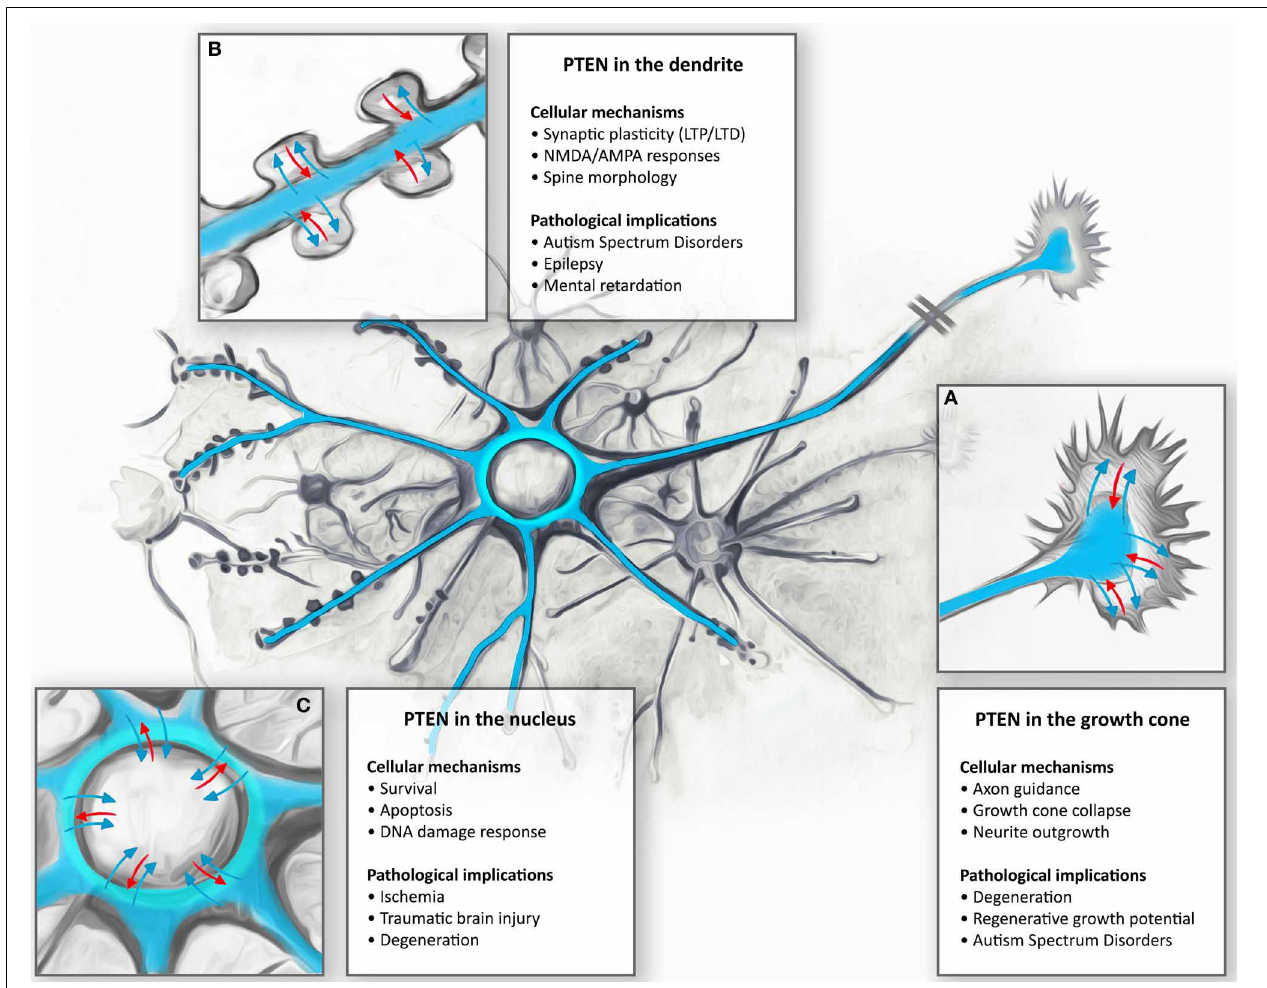
FIGURE 2 | Subcellular targeting and dynamic regulation of PTEN in neurons: Schematic illustration demonstrating dynamic distributions of PTEN in different neuronal compartments. (A) During neuronal development, PTEN is enriched in the axons and dendrites. Here, PTEN is thought to function in the regulation of growth cone dynamics during axonal navigation, in particular by inhibiting neurite outgrowth or mediating growth cone collapse responses. Consequently, PTEN-loss results in increased regenerative growth of axons in spinal cord injury models as well as protecting neurons during degeneration. (B) In mature CNS neurons PTEN is found in the dendrite. During NMDAR-dependent dendritic spine plasticity